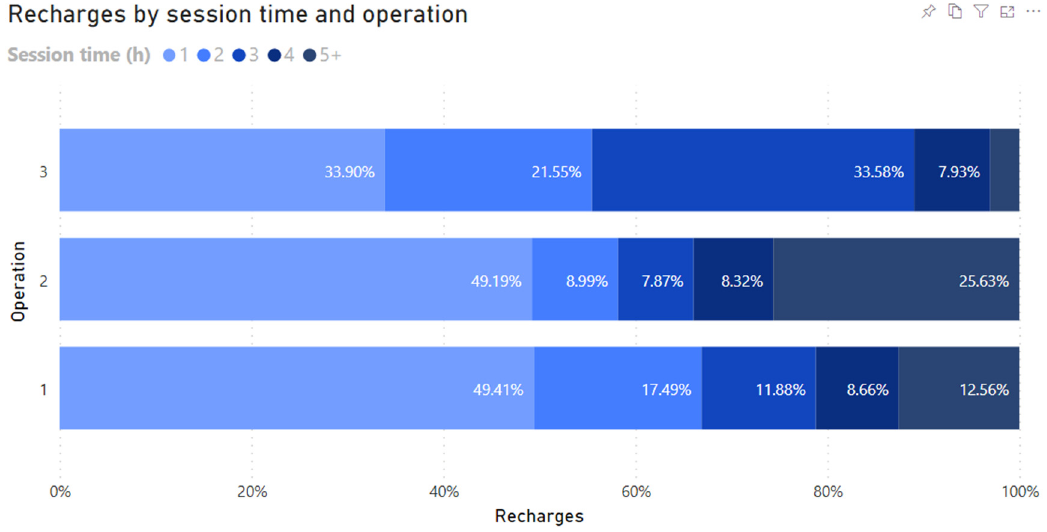
Figure 10. Recharging sessions by session time and operation.